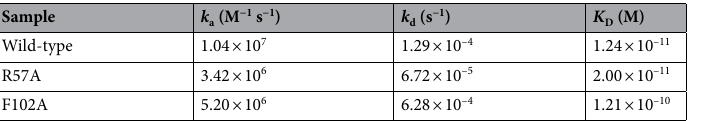
Table 3. Binding kinetics of anti-green fluorescent protein mutant nanobodies with R57A or F102A mutations. These mutants were not fused with peptide barcodes.